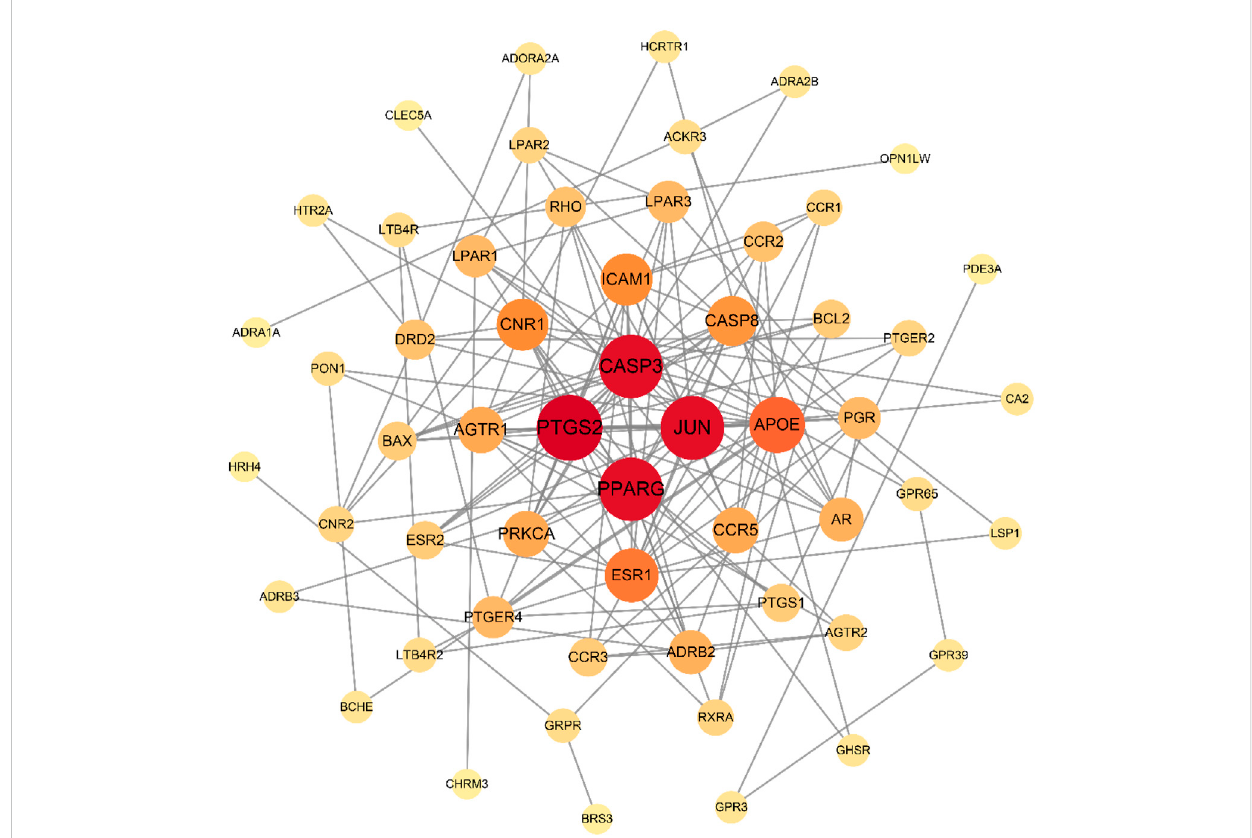
FIGURE 5 PPI network of SA for RA. A total of 56 nodes and 160 lines are included. The larger the node, the redder the color, the larger the degree. The more lines between nodes, the larger the between centrality. The larger the degree and between centrality, the more important the node is.